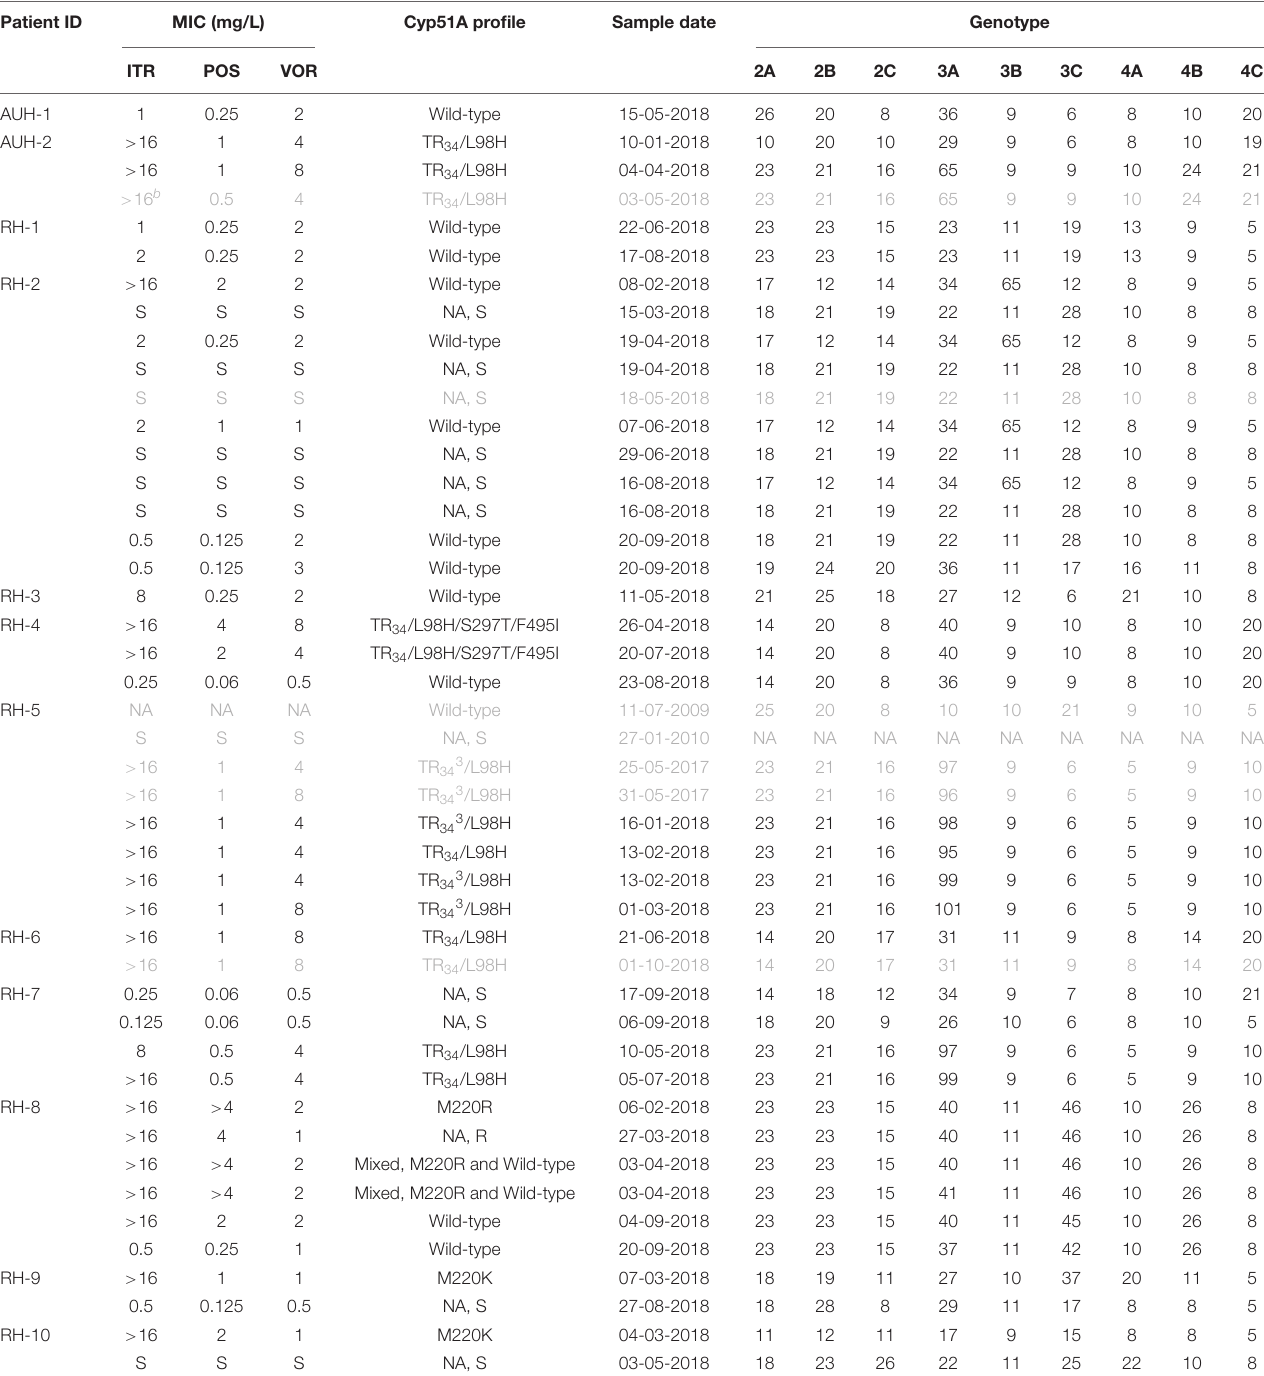
TABLE 3 | Detailed susceptibility pattern and STRAf genotyping of all Aspergillus fumigatus isolates from patients harboring isolates with decreased azole susceptibility. Patient ID MIC